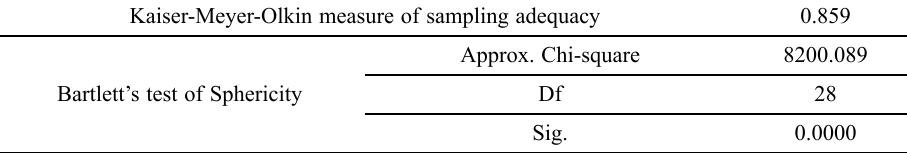
Table 2. Results of KMO and Bartlett’s